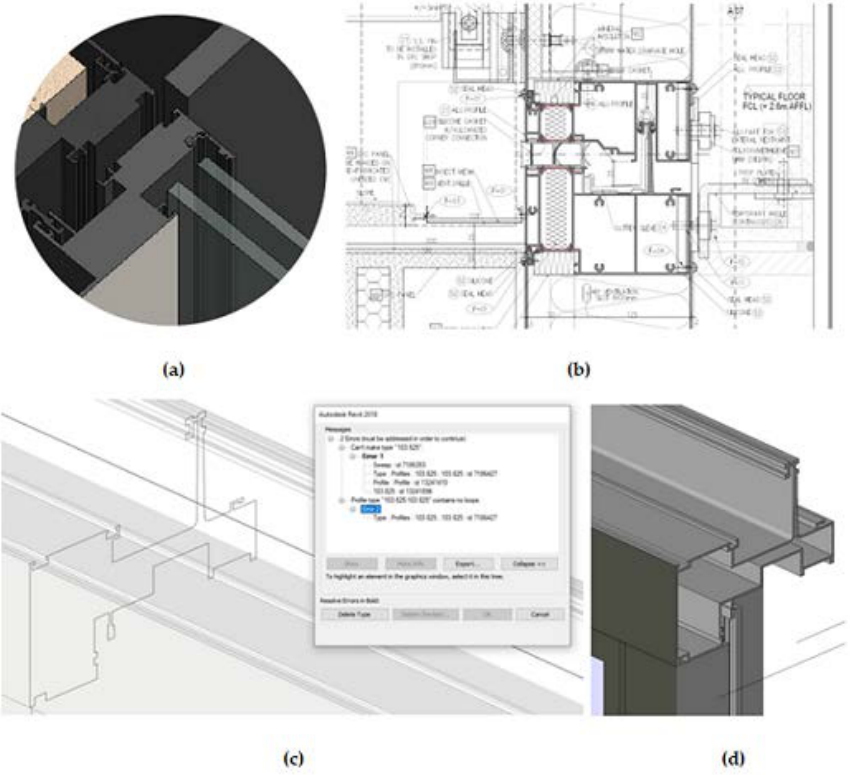
Figure 14. Void curtainwall mullion in the model versus a detailed curtain wall mullion: ( a ) Curtain wall mullion void drawing in Portland Place Revit model. ( b ) Actual drawing of the mullion. ( c ) Error window when converting the void item to a detailed mullion. ( d ) Curtain wall mullion detailed model in